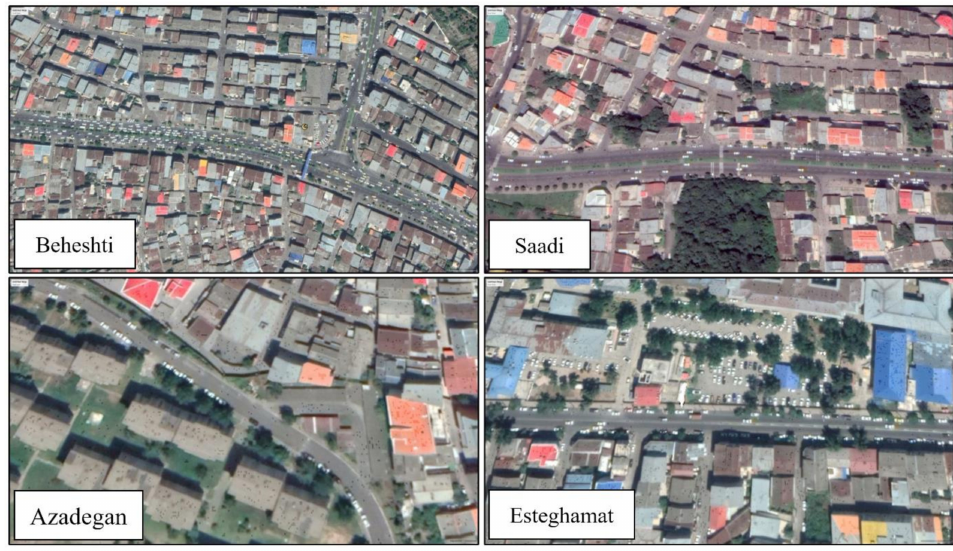
Figure 1. Satellite images of the selected roadway